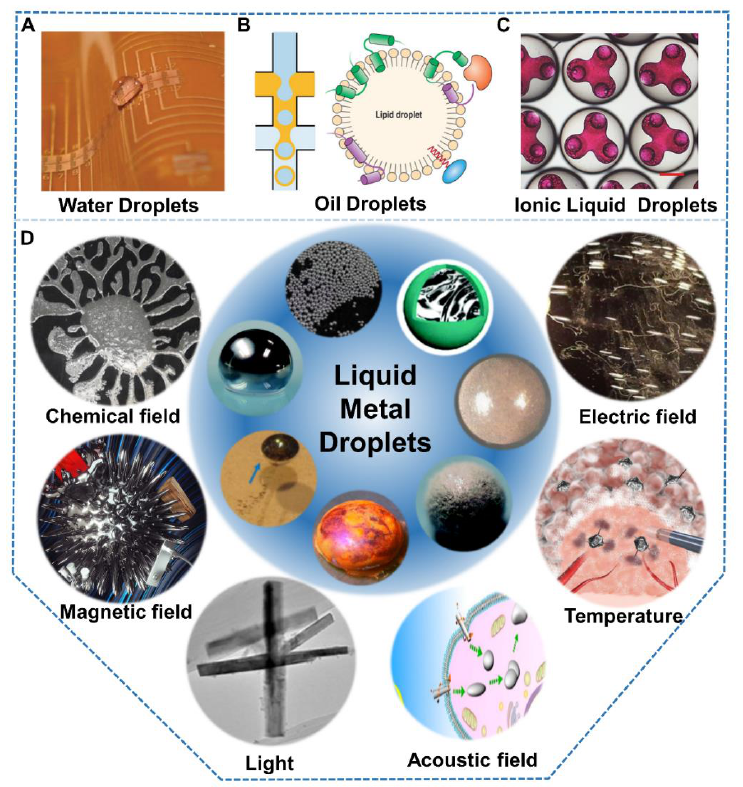
Figure 1. Different droplets. Common droplets including ( A ) water droplets. Reprinted with per-